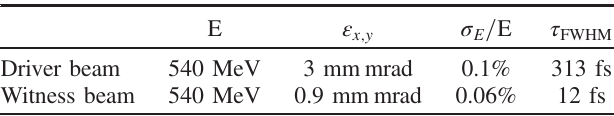
TABLE IV. Beam parameters at the plasma entrance for scheme 4A